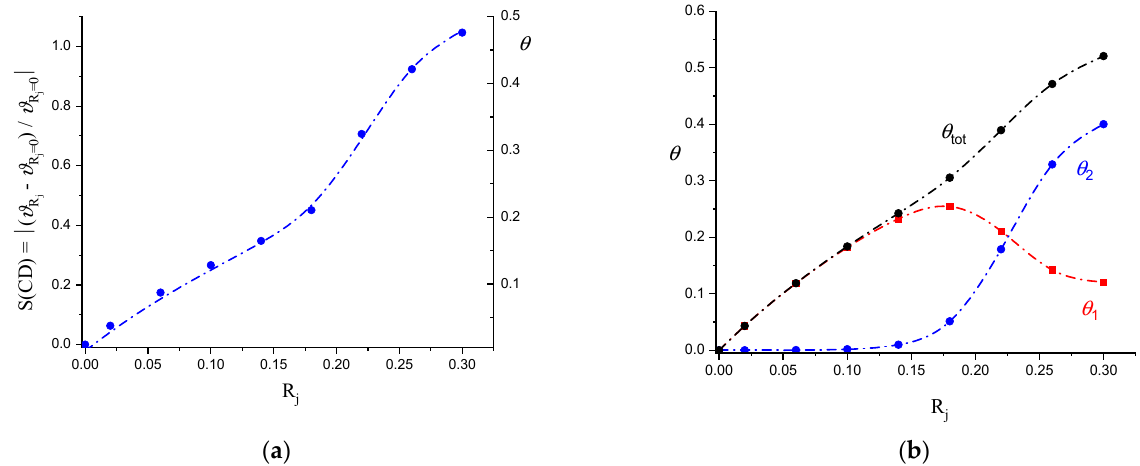
Figure 4. ( a ) CD, alginate—Dependence of the absolute value of the “specific” change of the molar ellipticity of sodium alginate as a function of the calcium-to-polymer molar ratio R j . Blue full circles, experimental data (bimodal); blue dash-dotted curve, fitting curve with the present method. ( b ) Fractions, alginate—fractions of chemically bound calcium ions by sodium alginate as a function of the molar ratio R j calculated from the fitting of the CD data of panel ( a ). Red symbols, fractions of bonding mode 1, θ 1 , blue symbols, fractions of bonding mode 2, θ 2